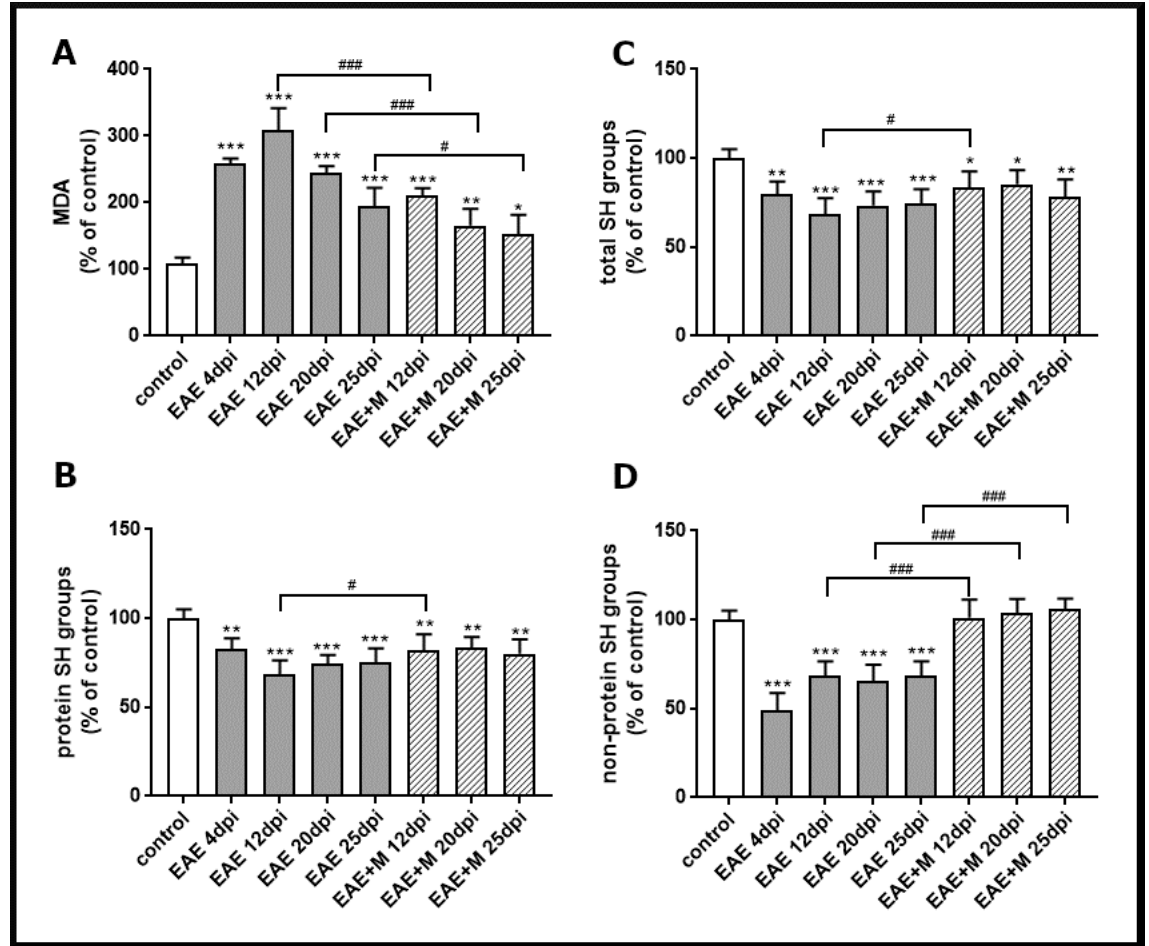
Figure 2. Thiobarbituric acid reactive substances (TBARS) content expressed as the level of malondialdehyde (MDA), a product of membrane lipid peroxidation ( A ), the level of total SH groups ( B ), protein SH groups ( C ), and non-protein SH groups ( D ) in brain homogenate obtained from the control, experimental autoimmune encephalomyelitis (EAE) rats and memantine-treated EAE rats in different phases of the disease. The results are the means from n = 4 animals and are expressed as percentages of the control. * p <0.05, ** p <0.01, *** p < 0.001 significantly different vs. control rats. # p < 0.05, ### p <0.01 significantly different vs. untreated EAE rats (one-way ANOVA with post hoc Bonferroni’s test).